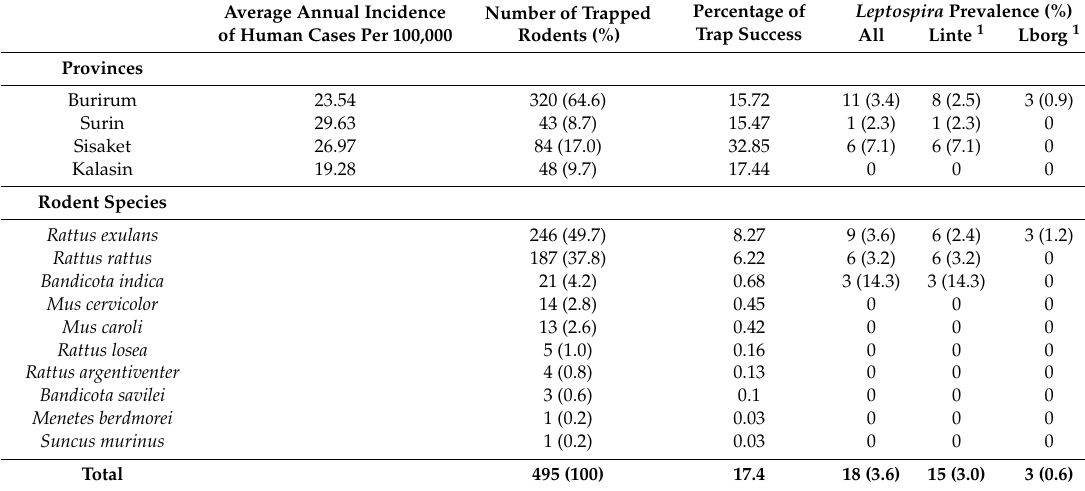
Table 1. Number of trapped rodents, PCR positive for Leptospira by study area and rodent species relative to the average annual incidence of human cases per 100,000 people reported to the MoPH in 2011 and